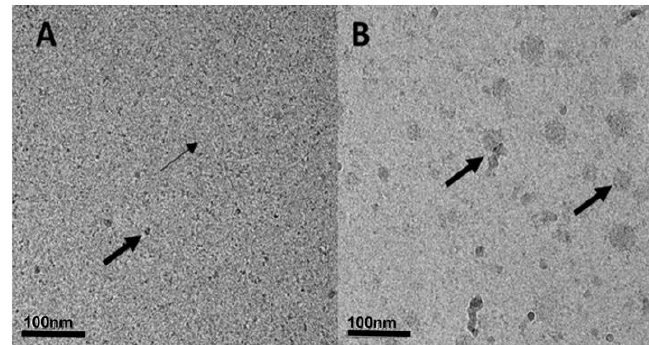
Figure 5. Cryogenic-transmission electron microscopy (Cryo-TEM) images of ( A ) FITC-HA-BSA NPs (40 μM). Small arrows indicate the FITC-HA-BSA NPs and large arrows indicate self-assembled aggregates of FITC-HA-BSA NPs. ( B ) Encapsulated PTX with a molar ratio of 2:1 PTX: FITC-HA-BSA conjugates; arrows indicate PTX aggregates and nanocrystals, to which FITC-HA-BSA NPs seem to be adsorbed.